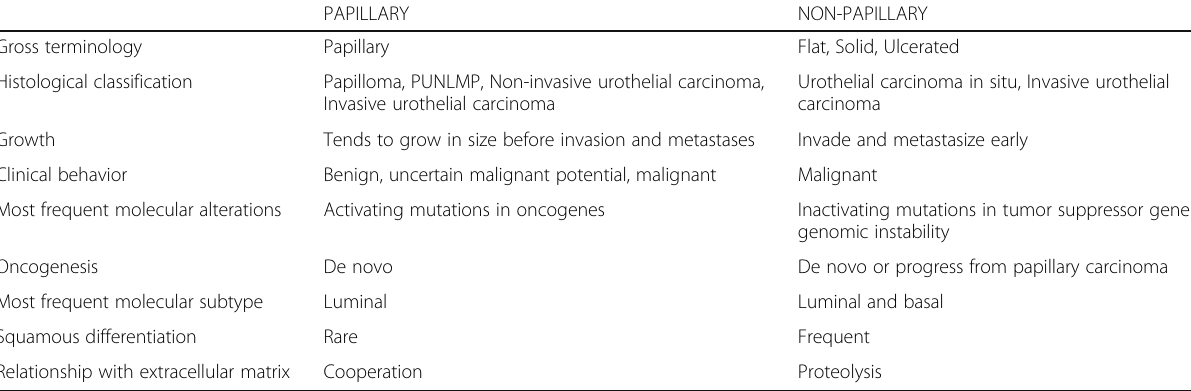
Table 1 Differences between papillary and non-papillary urothelial